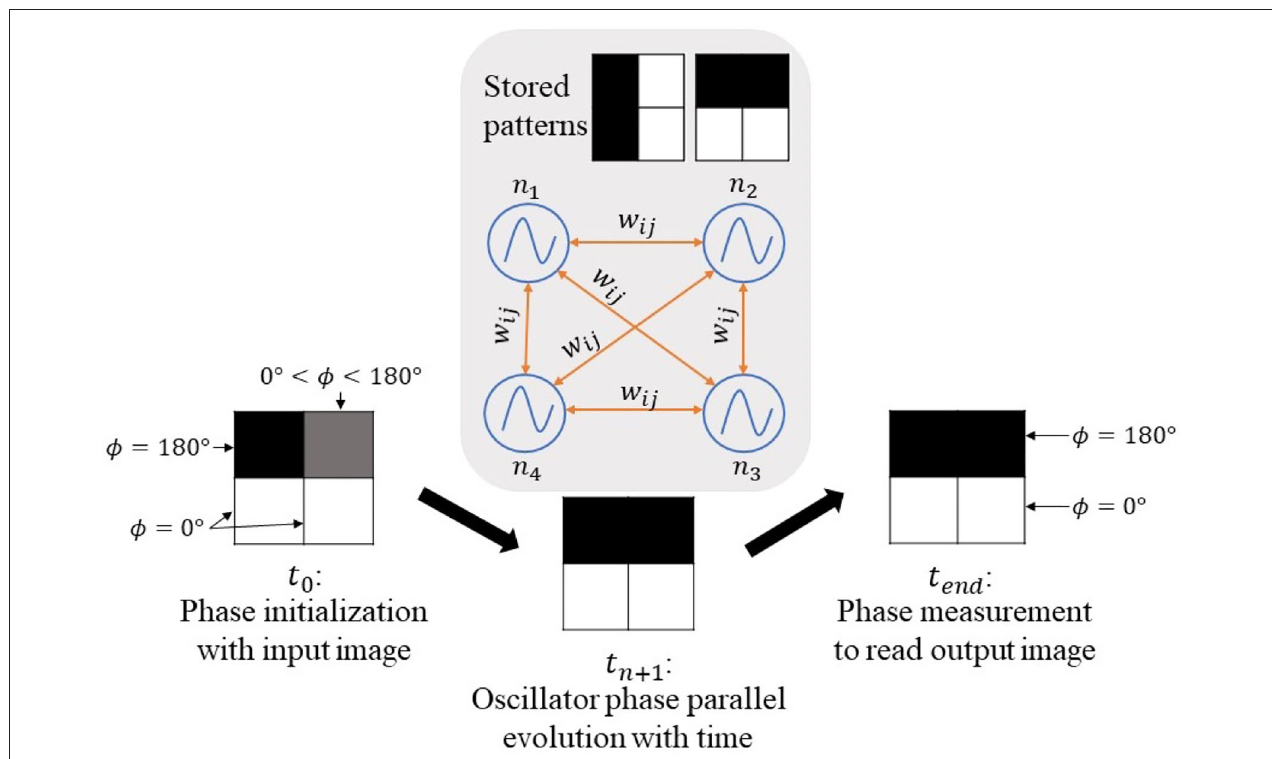
FIGURE 1 | Oscillatory Neural Network with 4 neurons n using associative memory capability to perform image recognition ( w ij corresponds to the weight between neurons n i and n j